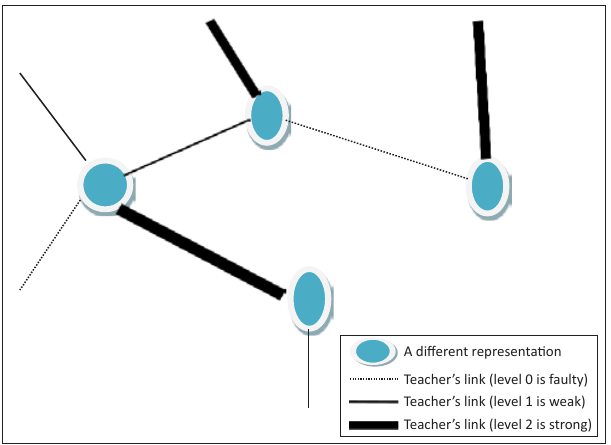
FIGURE 2: Representational-reasoning model, adapted from Barmby et al.